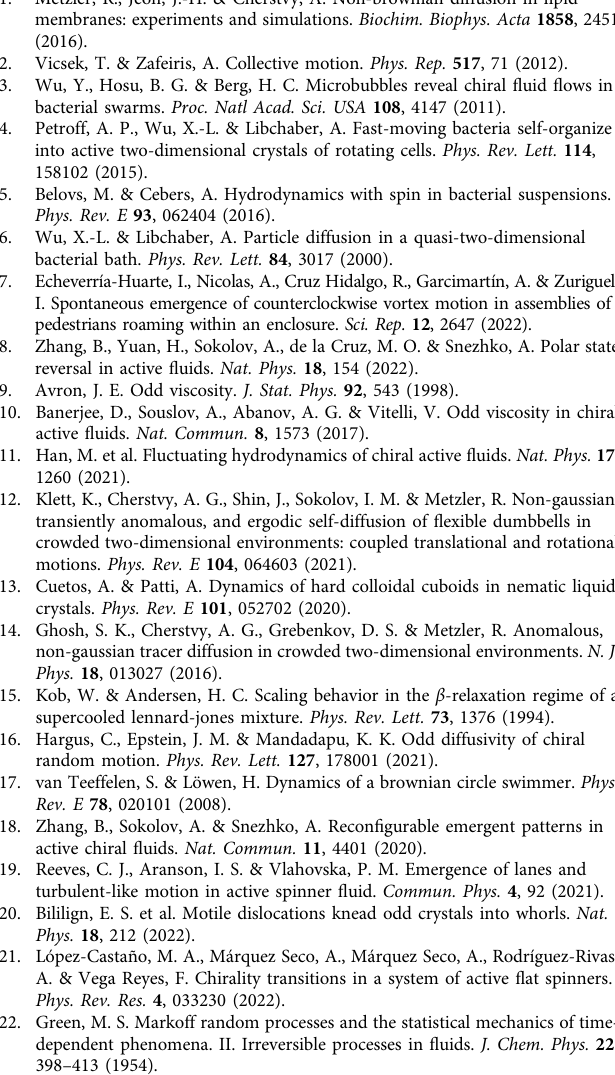
identical oblique blades that generate a clock-wise spinning as up fl ow passes through the disk. Turbulent vortexes from the up fl ow past the particles produces a stochastic translational motion as well. The rotors are located on top of a perfo- rated steel sheet (3mm diameter holes in a hexagonal pattern, with a 3mm spa- cing). This metallic grid is mounted on a box that guides an adjustable air current, generated by a fan and homogenized by means of a polyurethane foam layer that is placed below the metallic grid. The up fl ow intensity is adjusted so that all particles levitate at the minimum possible height over the grid, thus avoiding friction. The air fl ow has been produced by a SODECA HCT-71-6T-0.7 fan, and its uniformity was veri fi ed with an anemometer. Local deviations of air fl ow caudal are found to be within± 5%. Mean air fl ows ranged from 2.2 to 3.2 m/s. Particle movement is limited to a circular region with diameter L = 725± 1mm, located at the center of the metallic grid and delimited by walls of a height of 40mm. We used a variable number of disks N ranging from 3 to 70 (equivalent here to packing fractions ϕ = 0.03 to ϕ = 0.70). We have recorded a total of 120 experiments, varying the parameters (density and air current) and fi lmed with a Phantom VEO 410L high-speed camera. Each experiment movie contains a series of digital images at a rate of 250 fps, during 100 s. Our images achieve a spatial resolution of ~0.05% of the particle diameter. From each series of images (movie) we compute trajectories, vorticity and other whole-system properties. Trajectories are obtained by means of a modi fi ed version